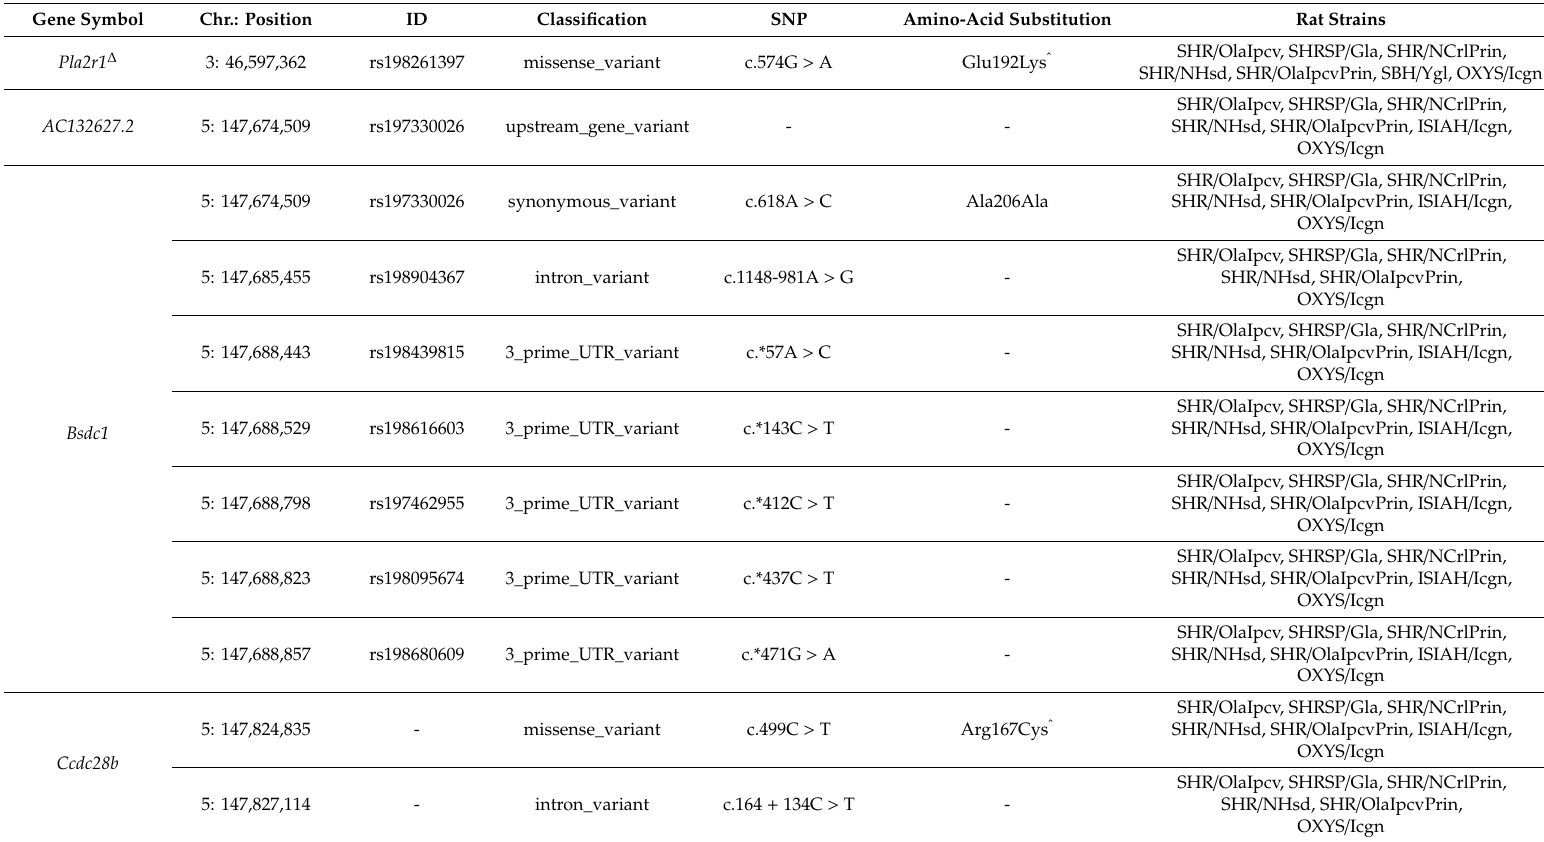
Table 1. SNPs that are most common among the hypertensive rat strains / substrains under study. Chr.—chromosome; ID—identifier. Gene